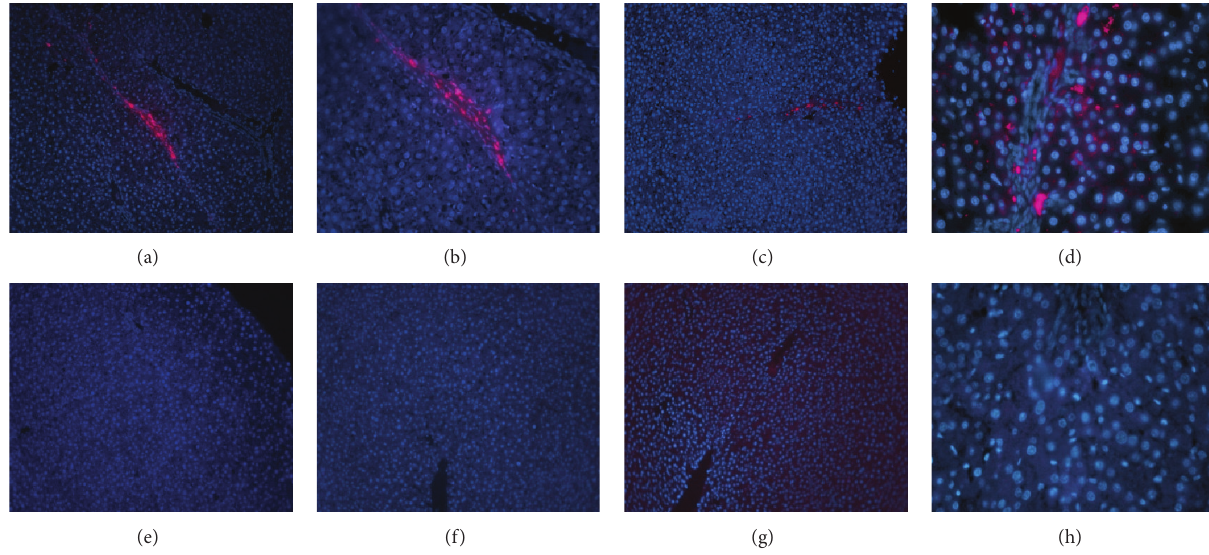
Figure 5: DAPI staining of rat liver lobe sections with CM-Dil-labeled ADSC six weeks after injection ((a), (b)) and twelve weeks after injection ((c), (d)). Control sections from animals six weeks ((e), (f)) and twelve weeks ((g), (h)) after injection of DMEM only, without ADSC. Magnification: (a), (c), (e), (f), and (g) 10x, (b) 20x, and (d) and (h) 40x. Pink signals show CM-Dil labeled ADSC and blue signals show DAPI-stained cell